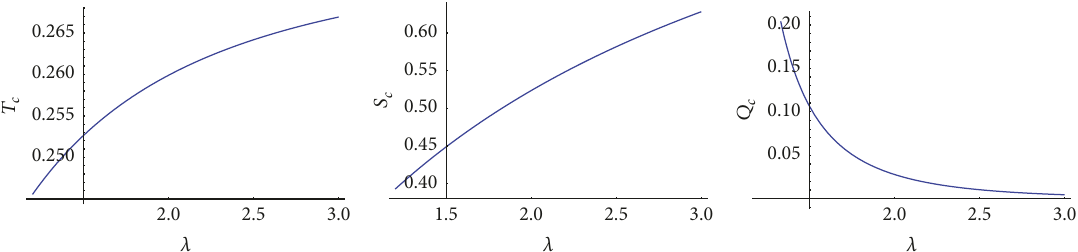
Figure 5: The figure shows the critical temperature 𝑇 𝑐 , the critical entropy 𝑆 𝑐 , and the critical charge 𝑄 𝑐 versus 𝜆 for 𝛾 = −1 . Here Λ = −3 .